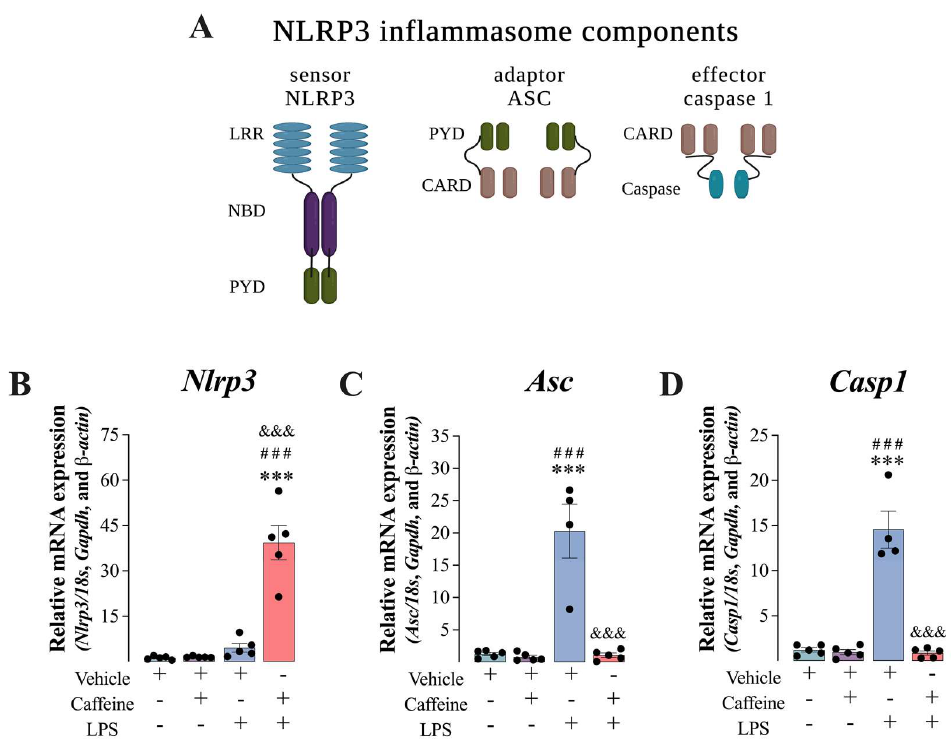
Figure 2. Caffeine administration rescued lipopolysaccharide (LPS)-induced Nrlp3 inflammasome components upregulation in the vastus lateralis muscle of mice. Adult Swiss male mice (3–5 months of age; body mass 45–50 g) received a single intraperitoneal (i.p.) injection of caffeine and/or LPS (See Materials and Methods for details). NLRP3 inflammasome consists of a sensor (Nlrp3), an adaptor (Asc) and an effector (Caspase-1) ( A ). The transcriptional profile of the components of the NLRP3 inflammasome Nlrp3 ( B ), Asc1 ( C ), and Casp1 ( D ). Gene expression raw data were normalized by the average of the Ct of the 18s , Gapdh and β -actin genes and calculated by the method (2 −ΔCt ). Bars represent the mean ± standard error of the mean of five independent experiments (animals) performed in technical duplicates. *** p < 0.001 vs. vehicle; ### p < 0.001 vs. to caffeine, and &&& p < 0.001